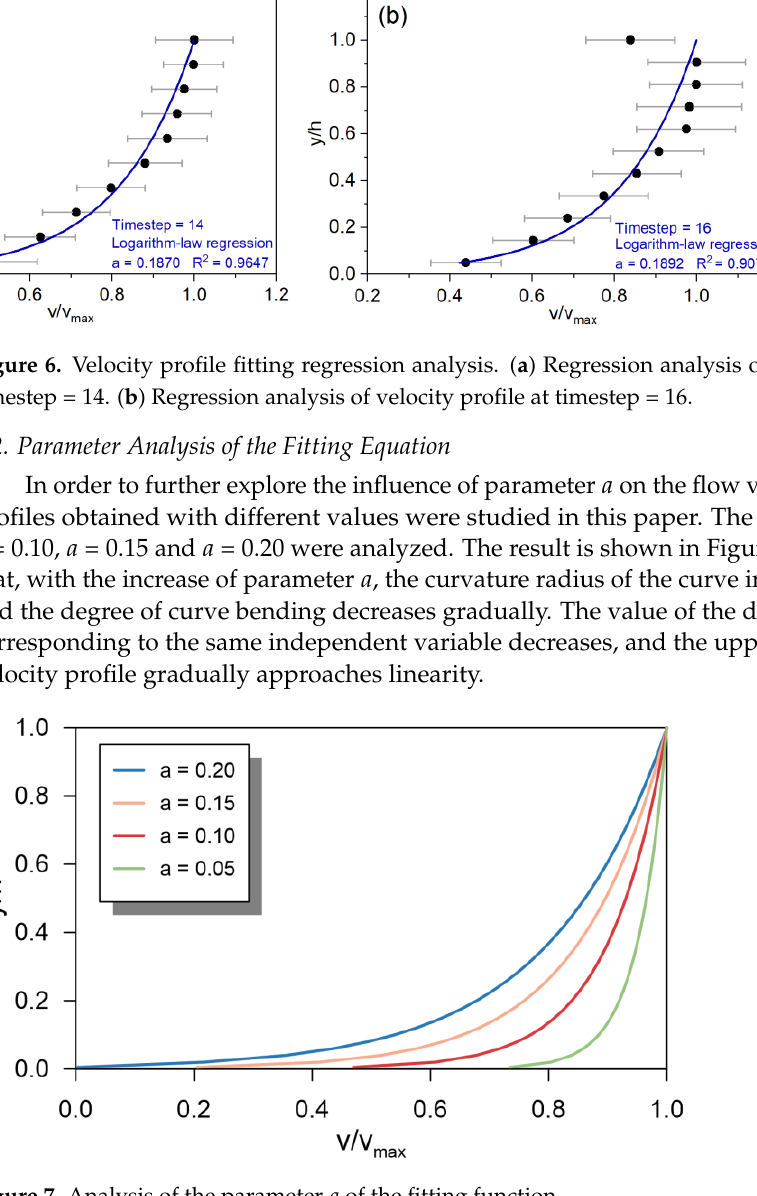
Figure 7. Analysis of the parameter 𝑎 of the fitting function.